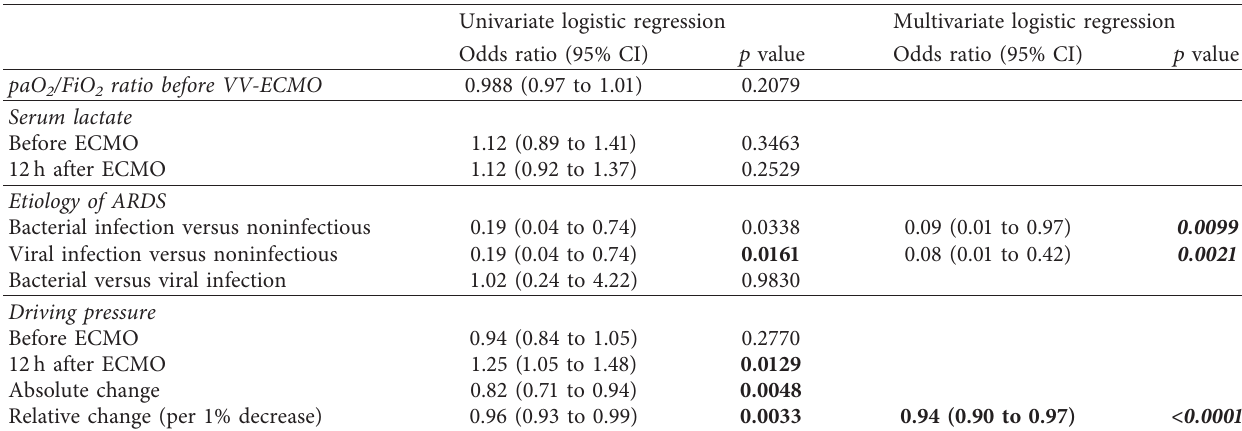
Figure 2: Driving pressures in the survivors and nonsurvivors. (a) Driving pressures ( Δ P ; mbar) in the nonsurviving and surviving patients receiving extracorporeal membrane oxygenation before and after initiation of therapy. (b) Percentage of Δ P changes before and after ECMO initiation (mean ± SD; n � 28 per group). Table 5: Factors associated with